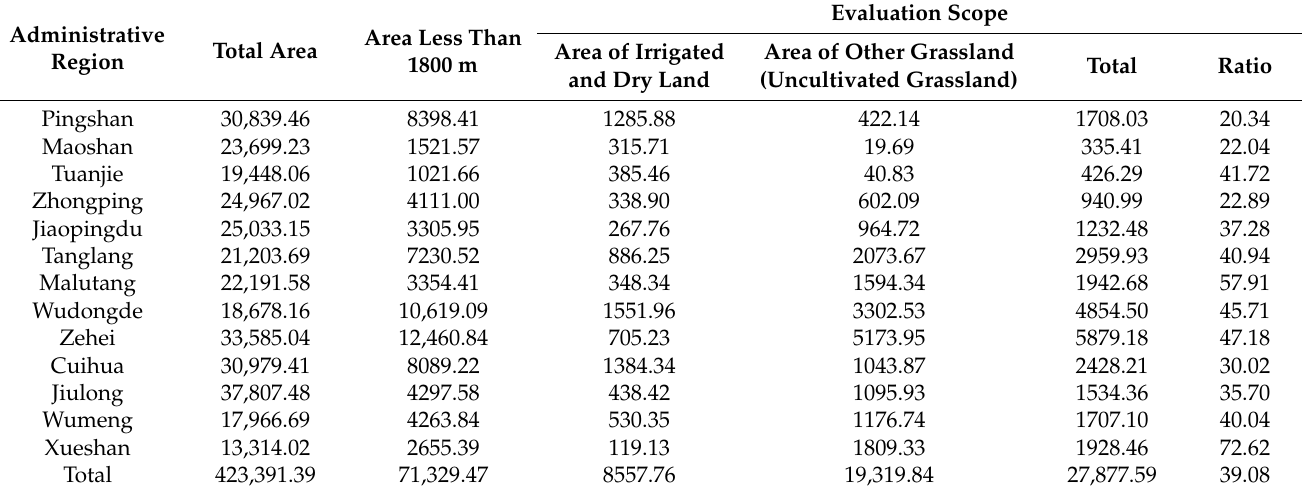
Table 5. Evaluation scope of land suitability of sorghum planting in Jinsha River Basin of Luquan County (Unit: ha,